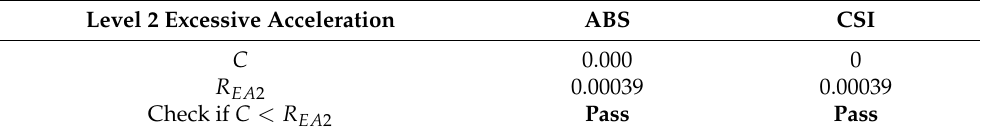
Table 29. Level 2 assessment of the excessive acceleration failure mode for the KCS container ship.